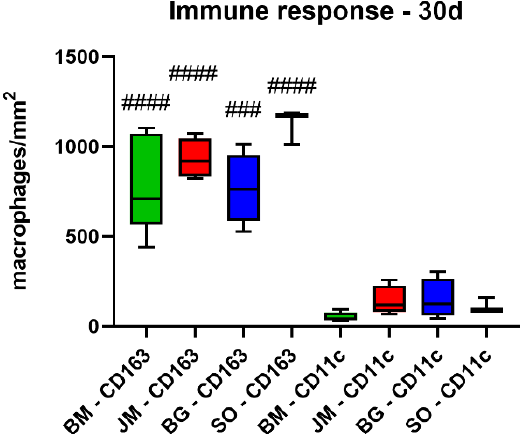
Figure 8. Results of the histomorphometrical measurements of the macrophage distribution at day 30 post implantationem (# = interindividual differences; ### p < 0.001, #### p < 0.0001).